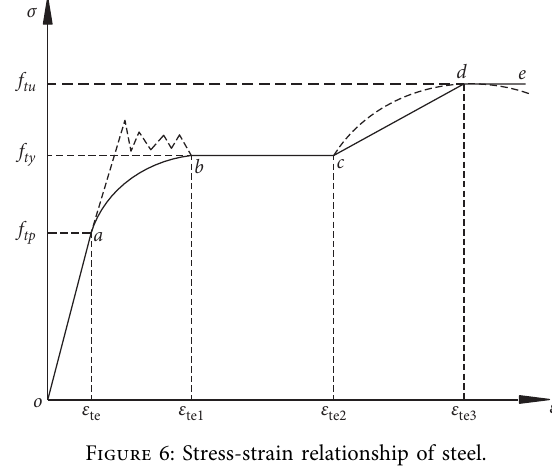
Figure 6: Stress-strain relationship of steel.